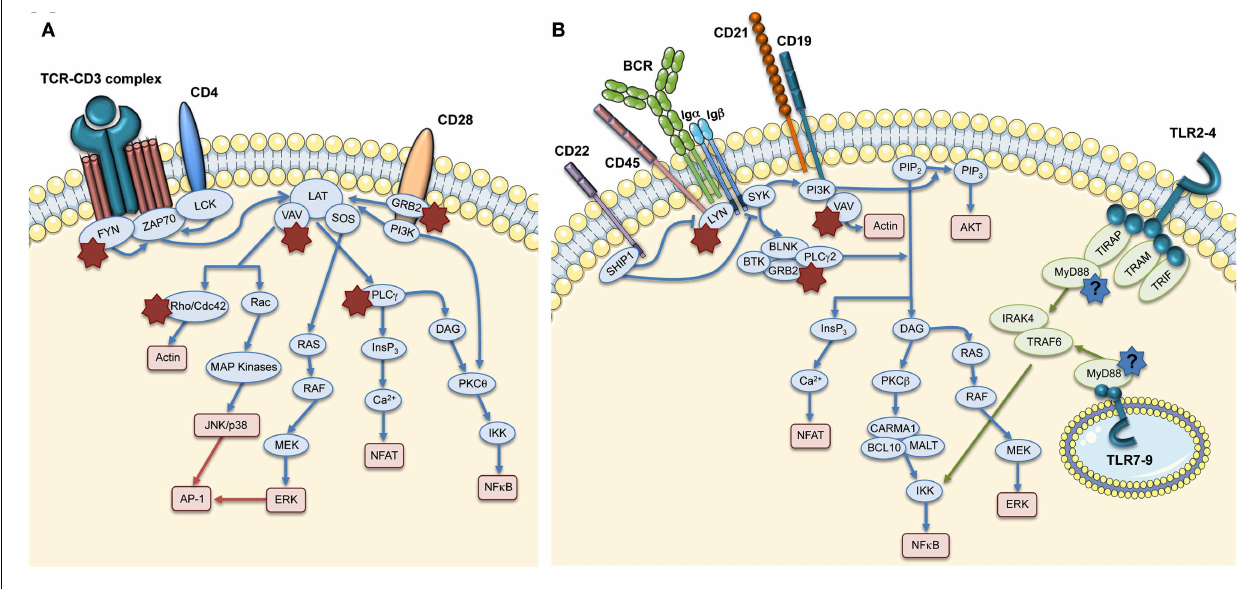
FIGURE 3 | Role ofWASP inTCR and BCR signaling pathways. The main signaling molecules (blue and green ovals) acting downstream of TCR (A) , BCR, andTLRs (B) are depicted.The red boxes indicate the main pathways induced downstream of these receptors.The role ofWASP in